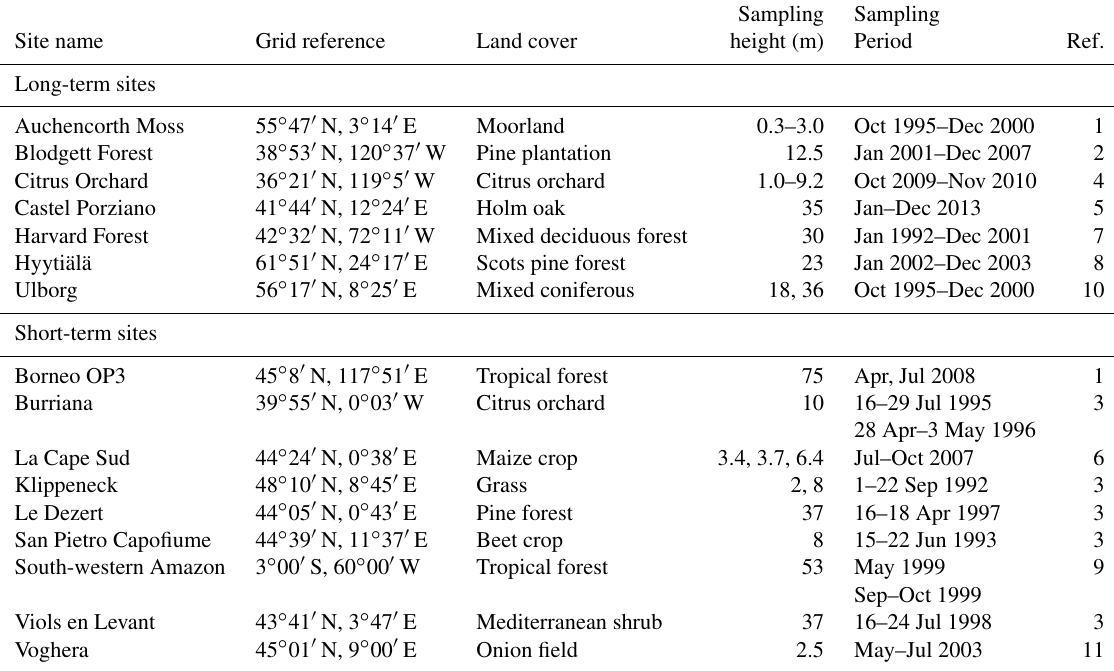
Table 3. Ozone surface dry deposition measurement sites (reproduced from Hardacre et al., 2015).